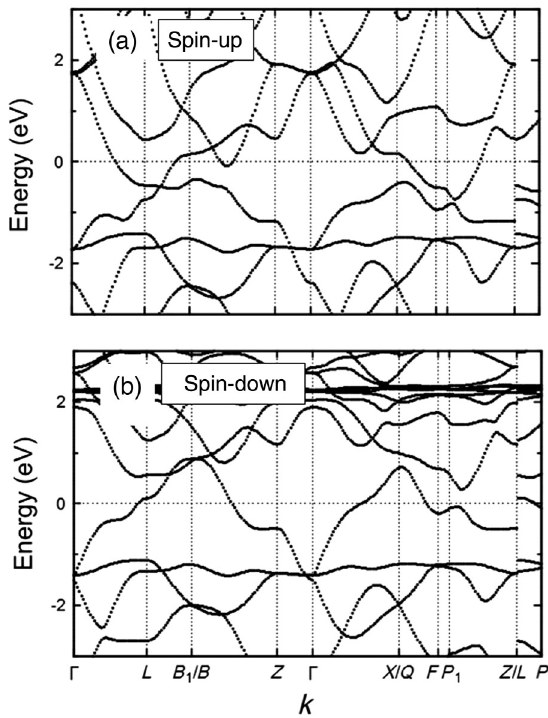
FIG. 11. Calculated band structure of Tb 2 C.